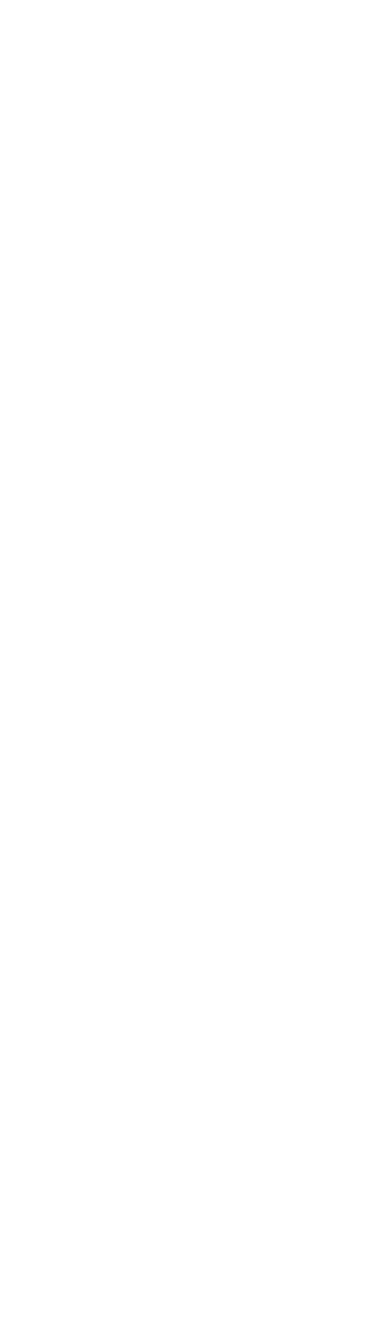
salt, analysis using qRT-PCR revealed signi fi cant differences in the expression of candidate genes in the two parents. Different treatments, such as the different growing environments of rice, differences between parents, and the determination of the germination rate at each salt concentration could affect the results of the QTL localization to varying degrees. In this experiment, we used salt stress tolerance as the only